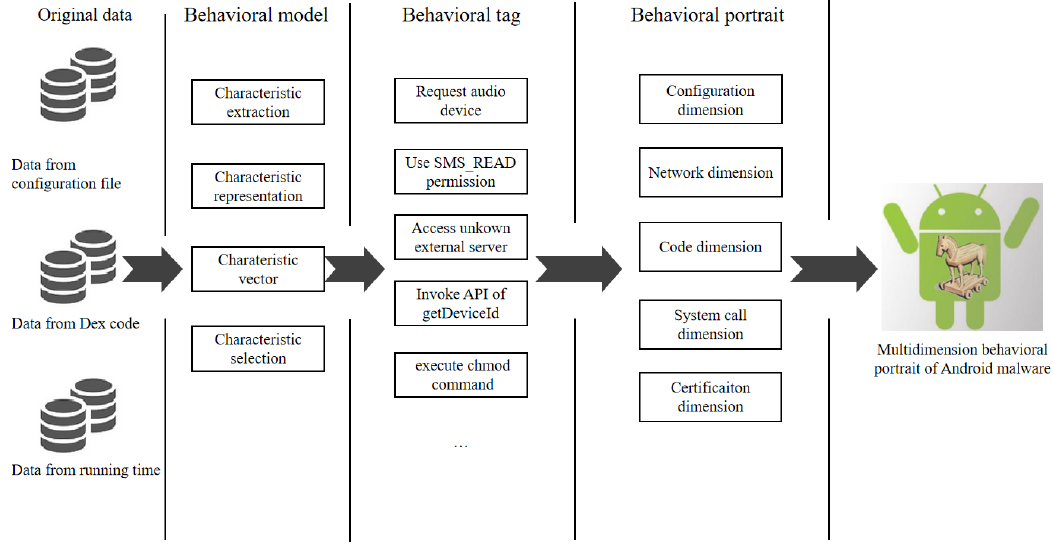
Figure 1. Architecture of DroidPortrait.